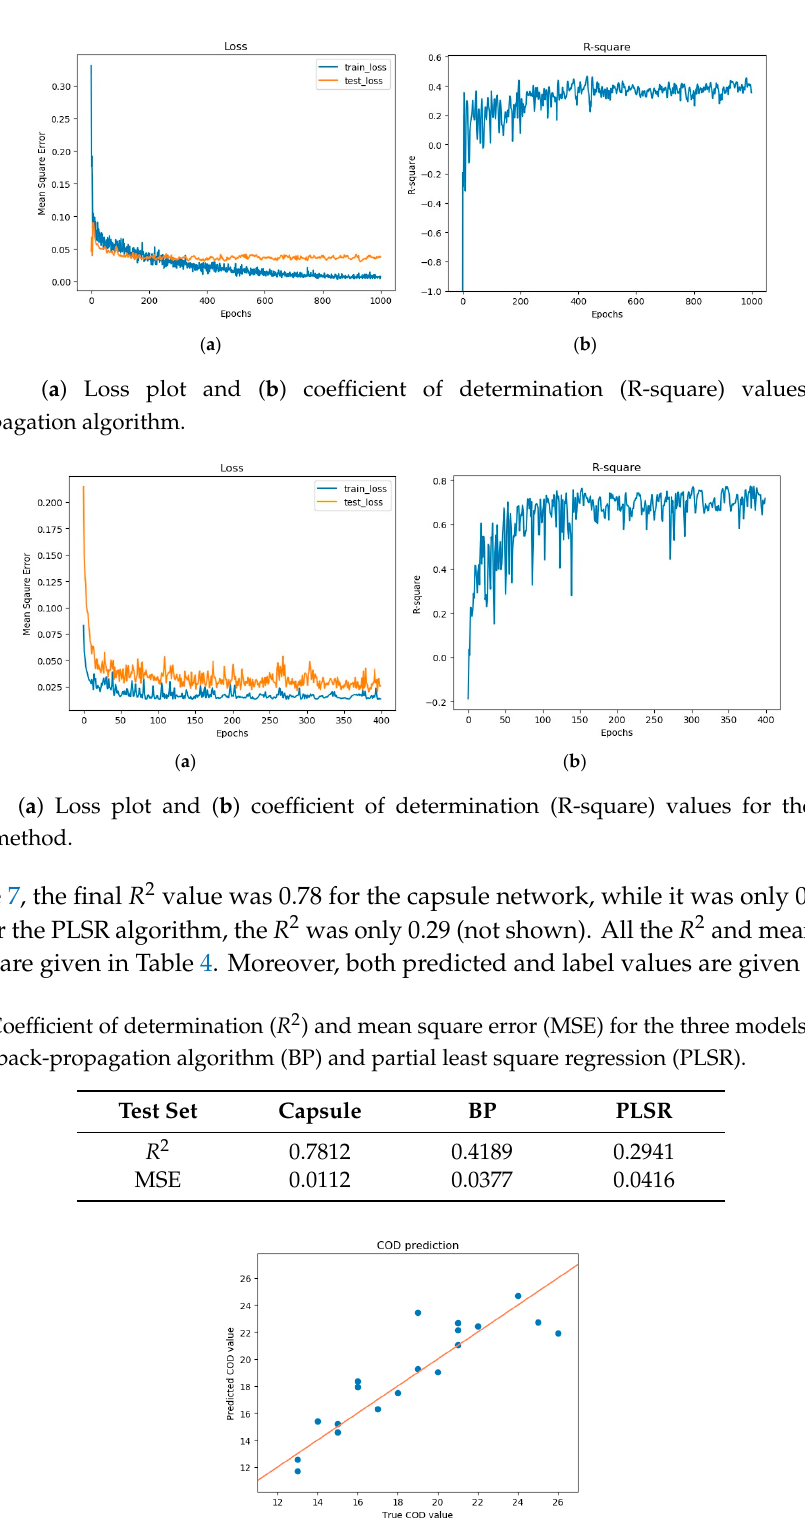
Table 4. Coefficient of determination ( R 2 ) and mean square error (MSE) for the three models: Capsule network, back-propagation algorithm (BP) and partial least square regression (PLSR).